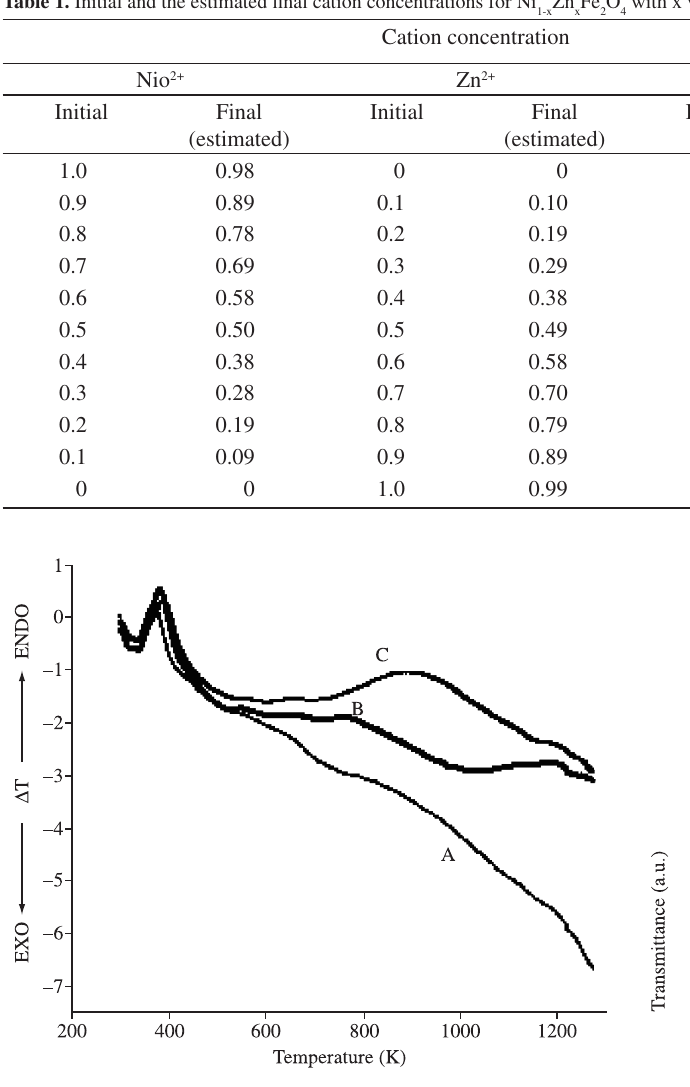
Table 1. Initial and the estimated final cation concentrations for Ni